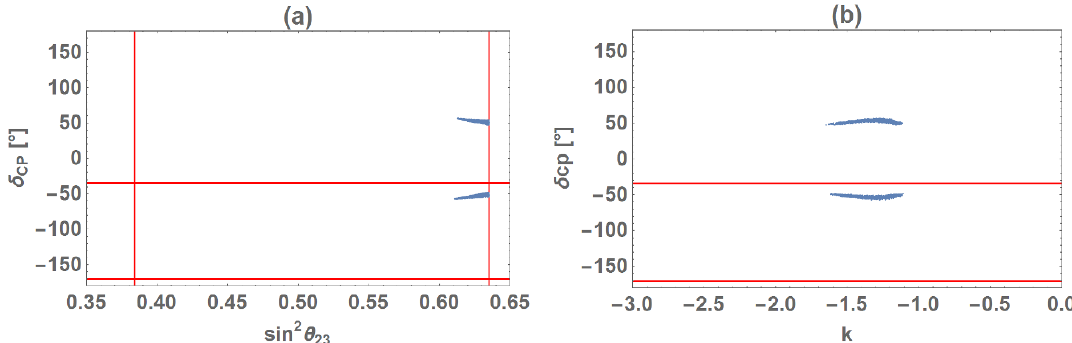
Figure 2 . Predictions for case II, where the red lines for sin 2 (cid:18) 23 and (cid:14) CP denote the experimental bounds of 3 (cid:27) (global analyses) and 2 (cid:27) (T2K) ranges, respectively: (a) (cid:14) CP versus sin 2 (cid:18) 23 and (b) (cid:14) CP versus k